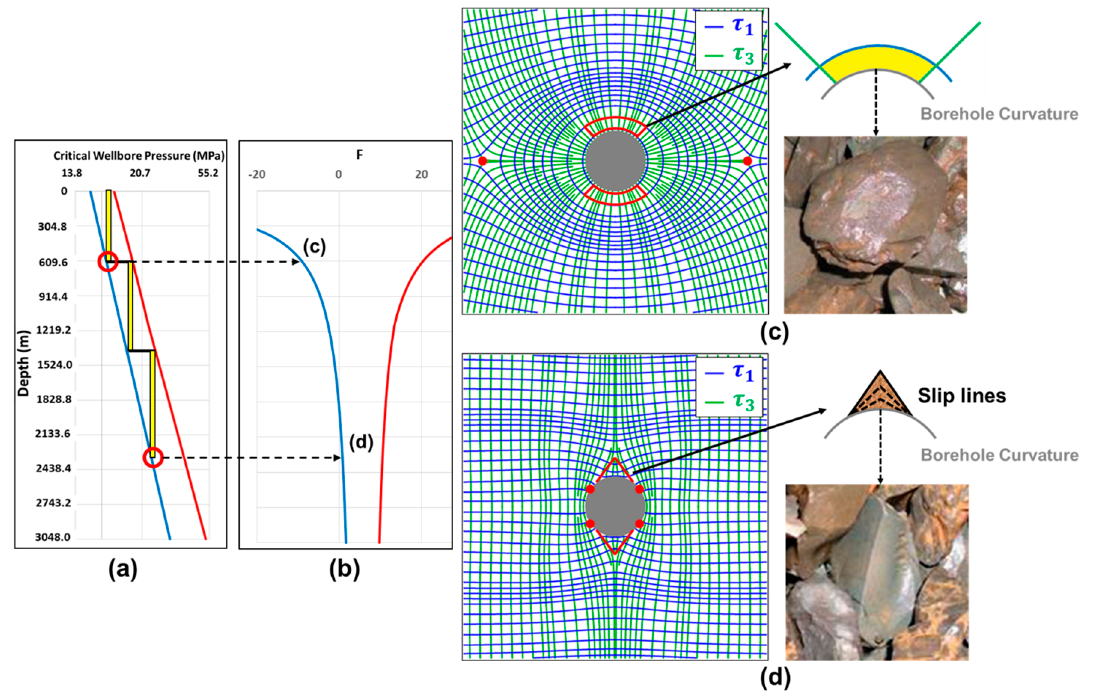
Figure 15. Casings of the wellbore segments placed between ( a ) the critical wellbore pressures and ( b ) the critical F values. ( c ) Gently curved caving shapes (spalling) from shallow formation. Cavings bounded by principal stress trajectories. ( d ) Angular caving shapes (shear failure). Cavings bounded by slip lines between two principal